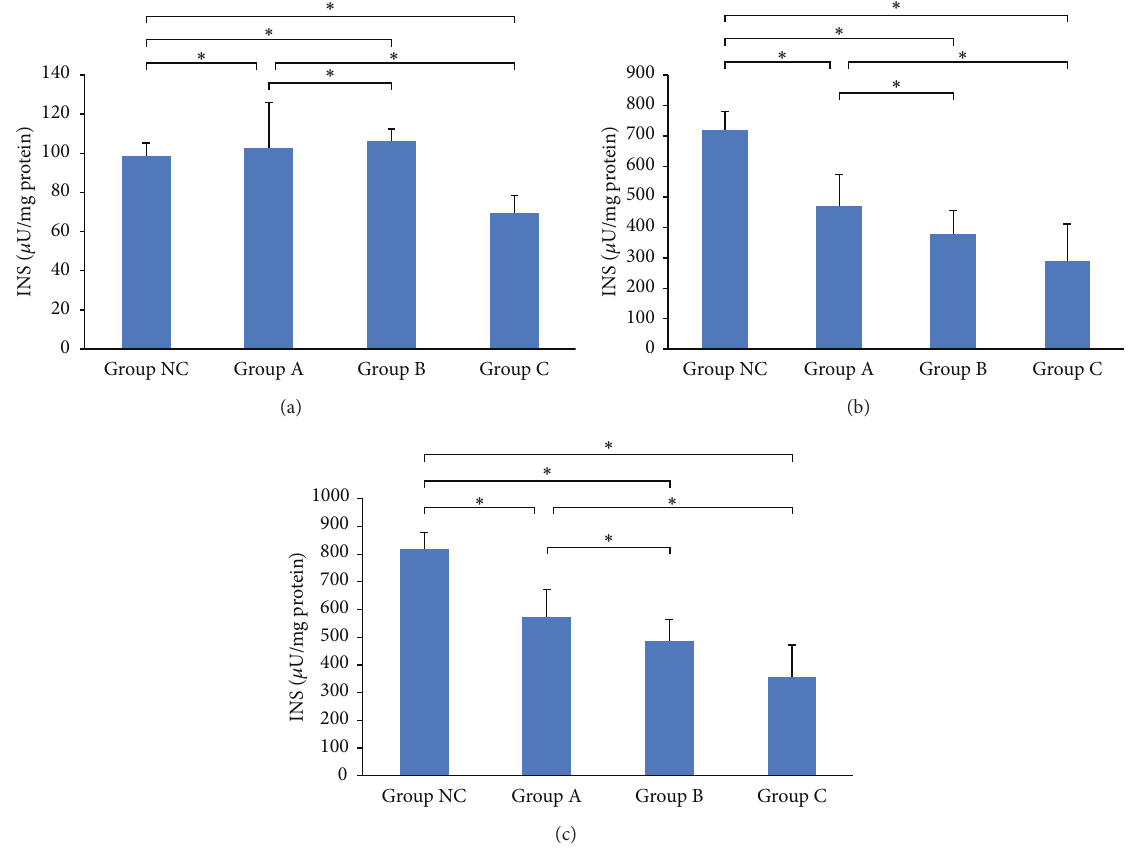
Figure 2: Effects of simvastatin on insulin content at high glucose level. (a) Insulin secretion. (b) Insulin content in MIN6 cells. (c) Total amount of insulin. INS indicates insulin-releasing test. ∗ 𝑃 < 0.05 and ∗∗ 𝑃 < 0.01 .